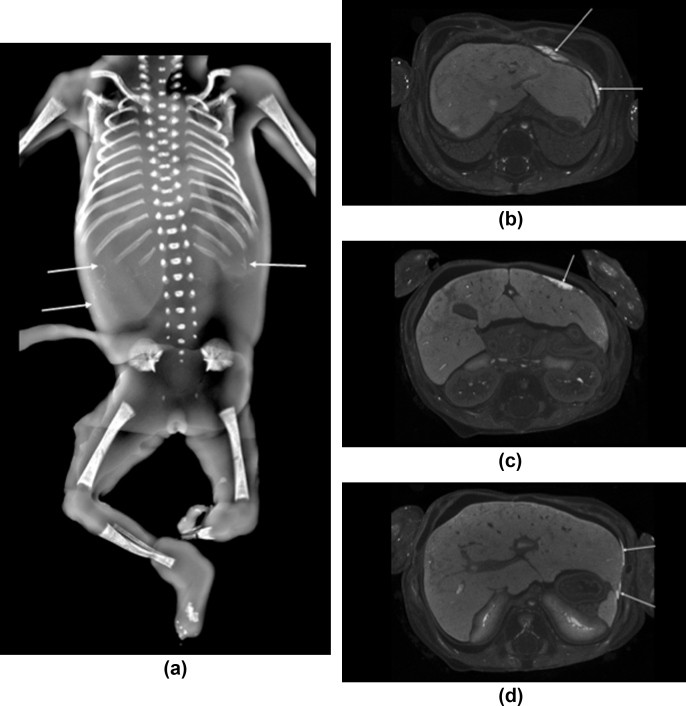
An 18-week gestational age fetus with amniotic band syndrome. Frontal view of the skeletal survey (a) demonstrates punctate flecks of upper abdominal calcification (white arrows). (b)Axial post-mortem micro-CT imaging of the upper abdomen, acquired at 40 μm resolution, demonstrates calcification along the left hemidiaphragm, surface of the left lobe of the liver and (c) within the right hepatic lobe as well as (d) along the subcapsular region of the left lobe of the liver (white arrows).